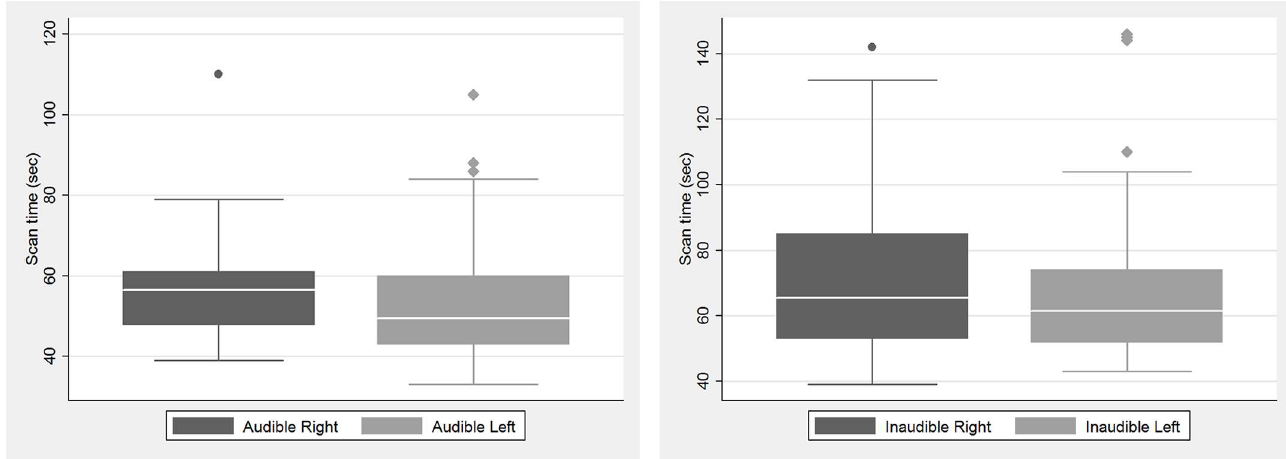
Fig 2. Scan time of right and left kidney. Box-and-whisker plots show Dopplersonographicscan time of right and left kidney during each session. There are no significant differences in the scan times between the right and left kidneys during the audible(A) and inaudible sessions